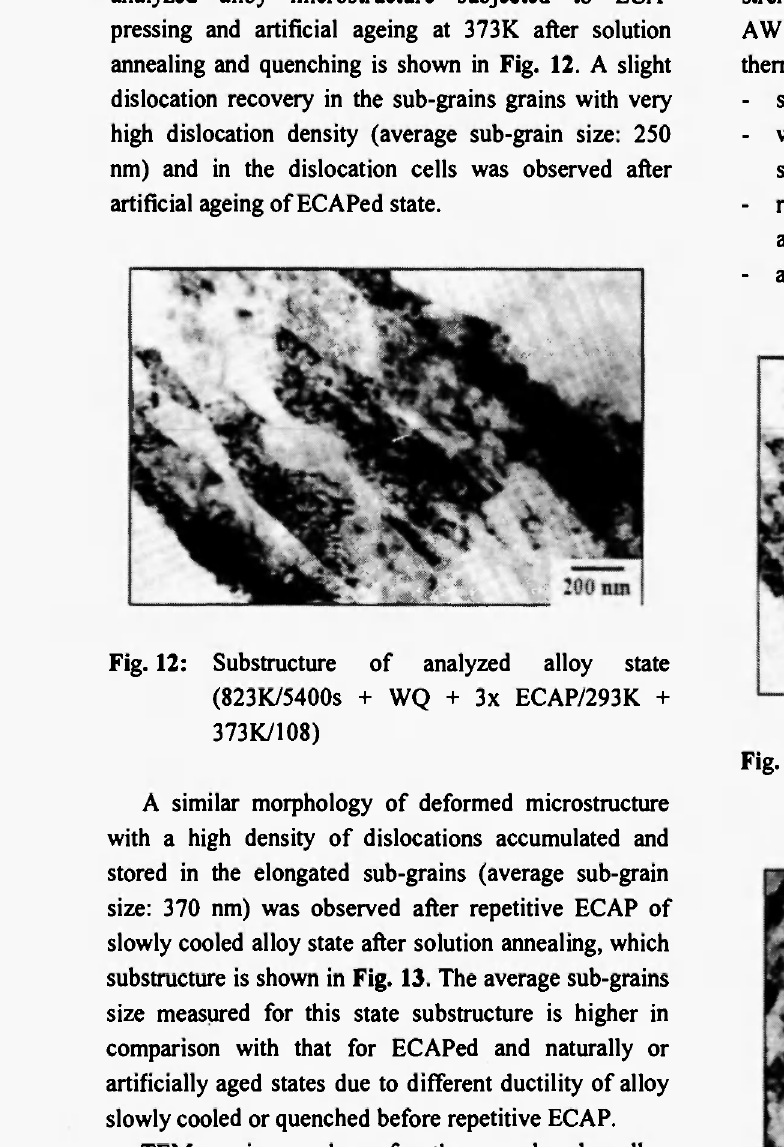
Fig. 13: Substructure of analyzed